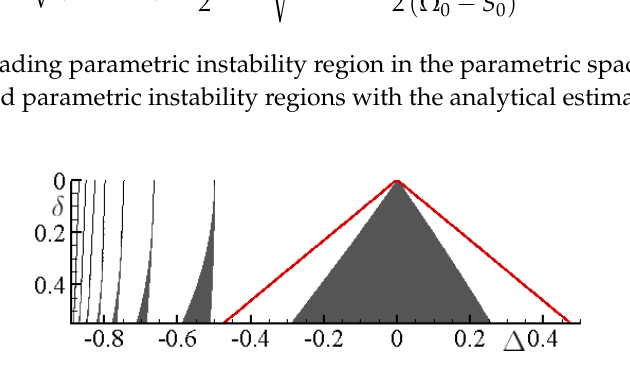
Figure 2. Parametric instability regions (dark - unbounded motion of the vorticity centre) in the parametric space ∆ = . The solid line corresponds to the analytical estimate